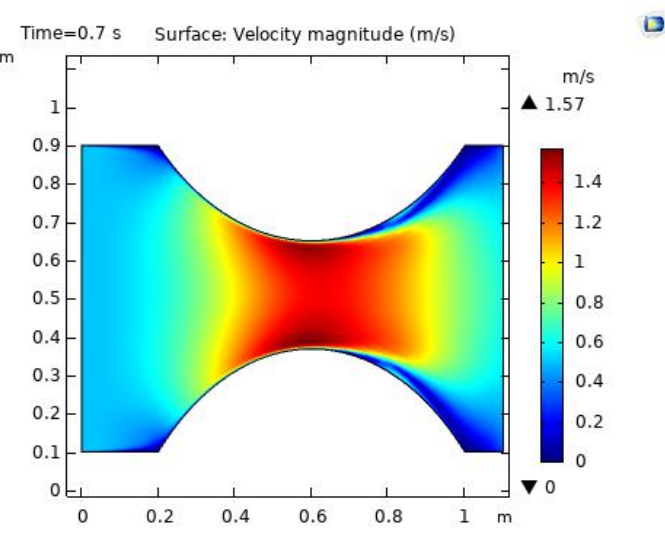
Figure 9. The velocity profile at t = 0.7 s.